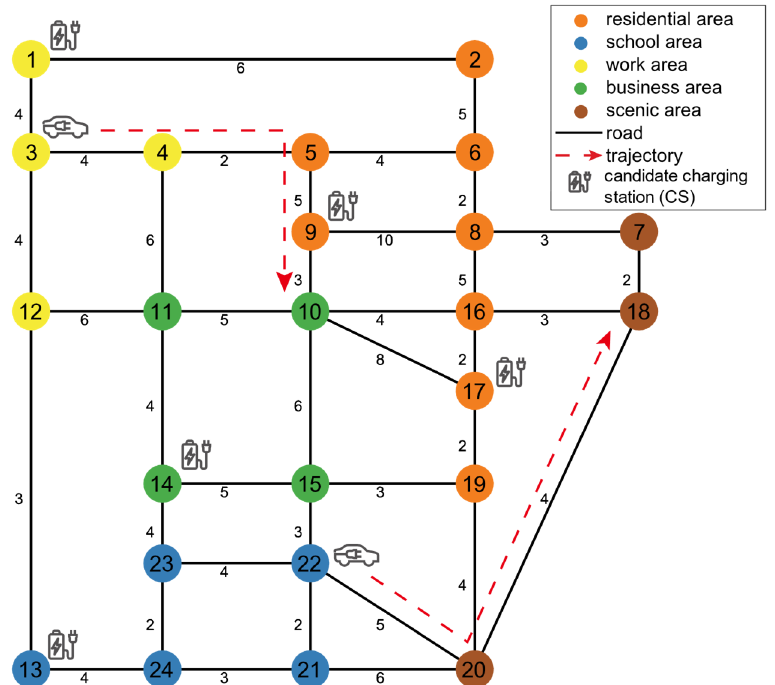
Figure 1. The topology of Sioux Falls road network with 24 nodes and 38 edges. Each node (24 in total) represents the road crossing, which corresponds to an urban functional zone (UFZ), and each edge (38 in total), with a number indicating the road length (km), illustrates the bidirectional road. The numbers on the nodes represent the ID of road crossings.